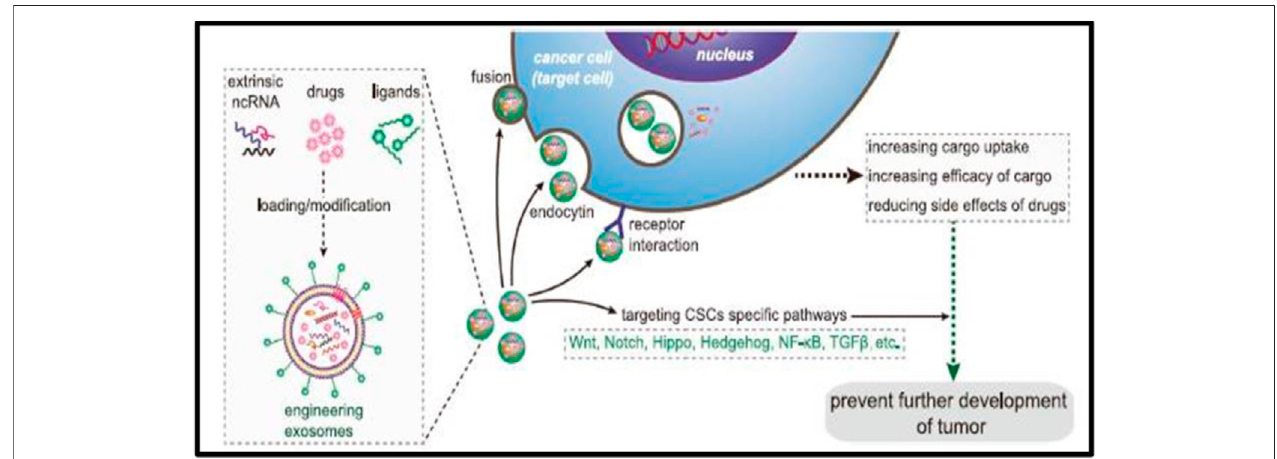
FIGURE 3 | Precisely targeting the tumor with engineering exosomes as a delivery carrier. Exosomes are carriers with natural delivery ability, which have the characteristics of precisely targeting and high bioavailability. After being loaded into exosomes, anticancer drugs and/or extrinsic ncRNA can directly target cancer cells or CSCs speci fi c pathways and prevent the further development of tumors. Additionally, the surfaces of exosomes can also be modi fi ed with the ligands corresponding to receptors overexpression on cancer cell surfaces, which improves the cellular uptake ef fi ciency of exosomes by cancer cells. ncRNA noncoding RNA, CSCs cancer stem